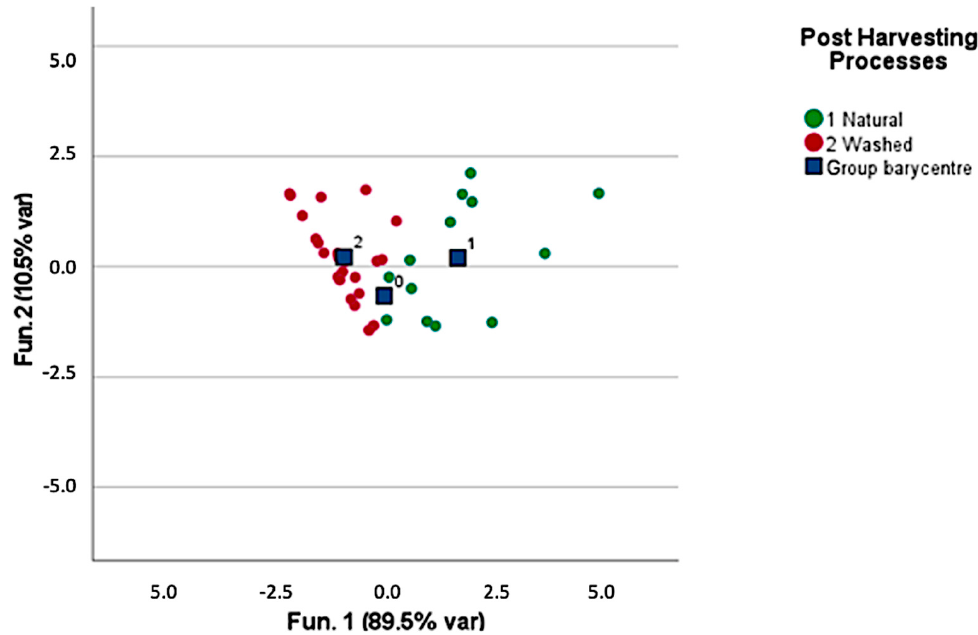
Figure 3. Discrimination between washed and natural post-harvesting processed green coffee sam ‐ ples.